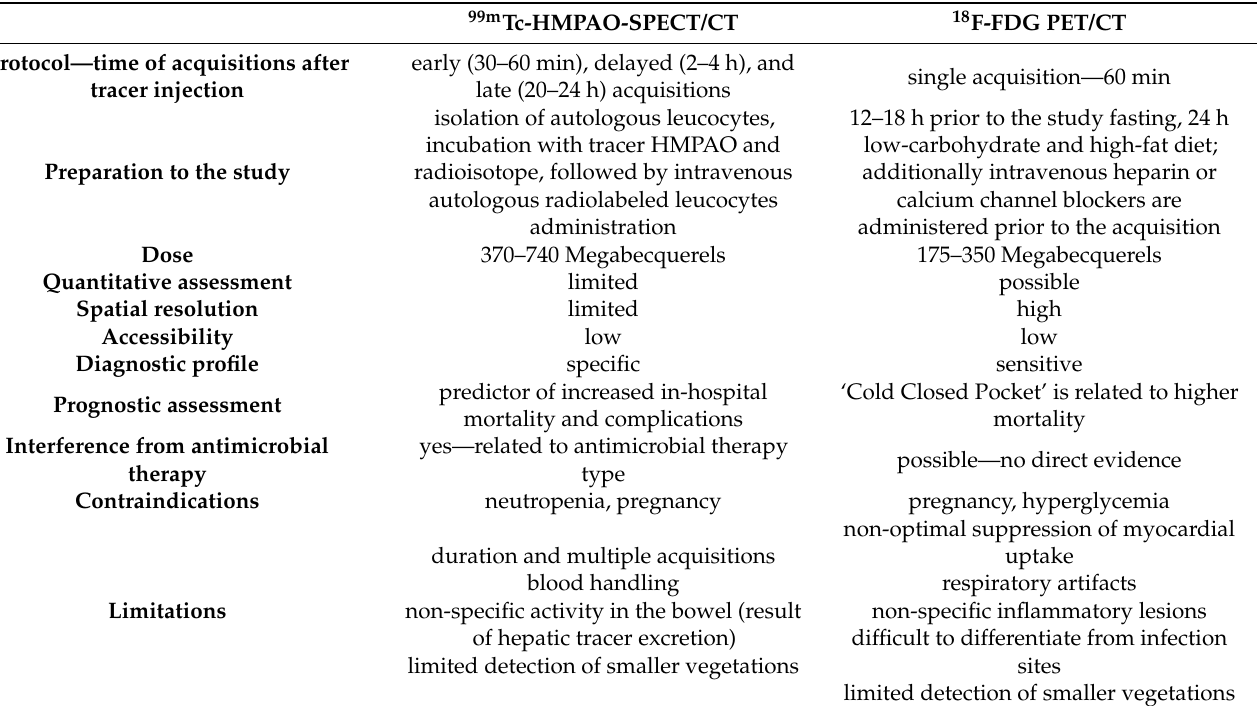
Abbreviations are listed in Tables 1 and 2 and Figure 1 legends.